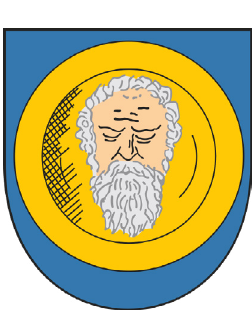
Figure 7. The former arms of Nowe